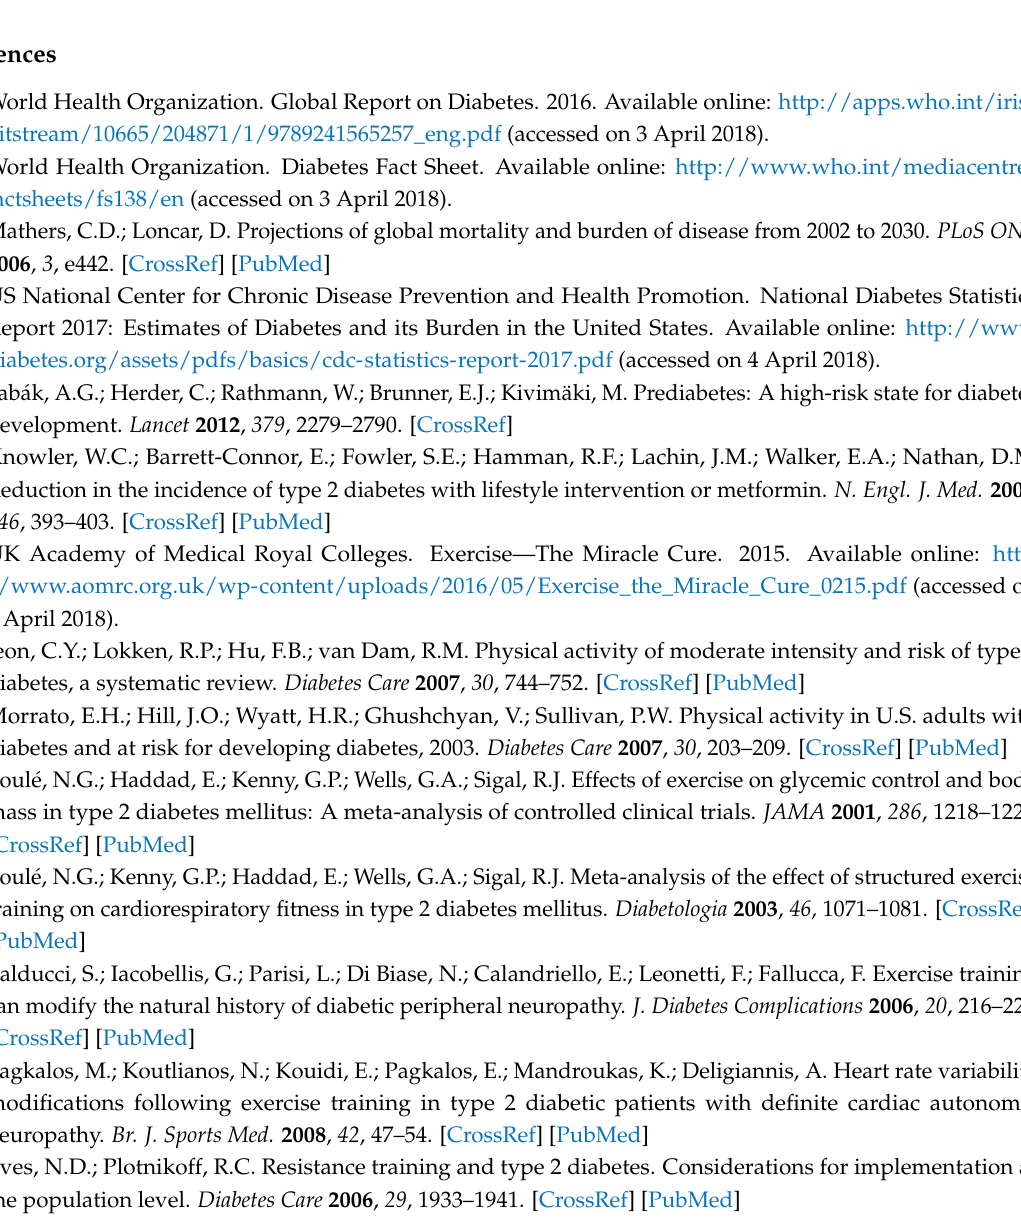
Figure S1: Flow diagram of study selection, Figure S2: Risk of bias assessment. Search strategy for PubMed: (“training” OR “exercise” OR “physical activity”) and (“diabetes” OR “prediabetes” OR “insulin resistance” OR “impaired glucose tolerance” OR “impaired fasting glucose” OR “leptin” OR “adiponectin” OR “adipokines”) and (“randomized controlled trial” OR “randomized” OR “clinical trials as topic” OR “placebo” OR “randomly” OR “trial”) not (“animals” NOT